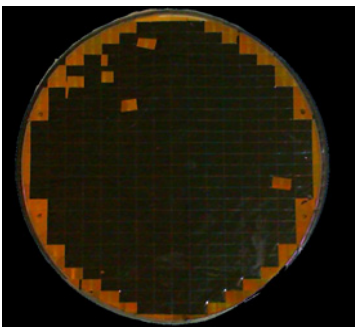
Figure 5. The wafer-region image after the position